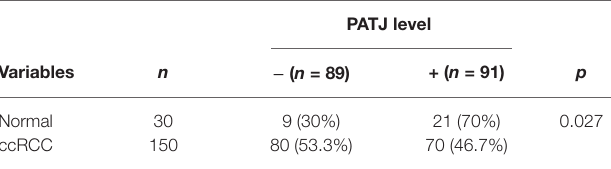
TABLE 4 | Differential expression of PATJ protein between ccRCC and adjacent normal kidney